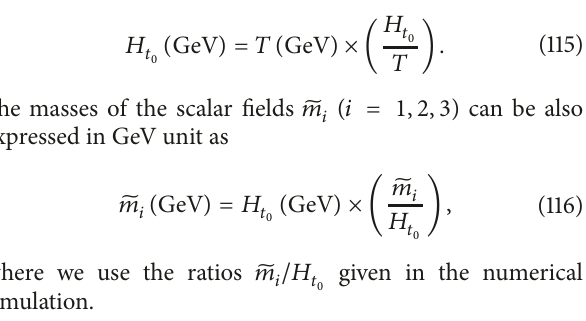
Figure 7: Dependence on frequency 𝜔 3, 0 of the time evolution of the PNA. We use the dimensionless time 𝑡 = 𝜔 푟 3, 0 (𝑥 0 − 𝑡 0 ) for horizontal axis and as a reference angular frequency, we choose 𝜔 푟 3, 0 = 0.35 . We fix parameters (̃𝑚 1 , ̃𝑚 2 ,𝐵, 𝑇,𝐻 푡 The black and orange lines show the cases 𝜔 3, 0 = 0.35 and 0.9 , respectively (left plot). The black and green lines show the cases 𝜔 3, 0 = 0.35 and 1.5 , respectively (right